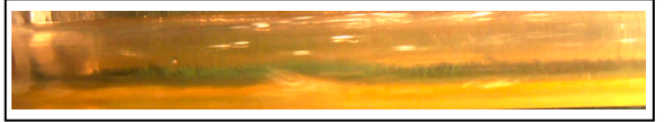
Figure 8. Annular wavy flow regime (V sl =0.1 m/s , V sg = 12.75 m/s).